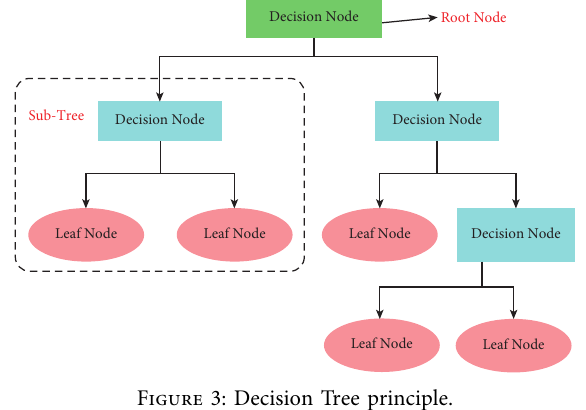
Figure 3: Decision Tree principle.